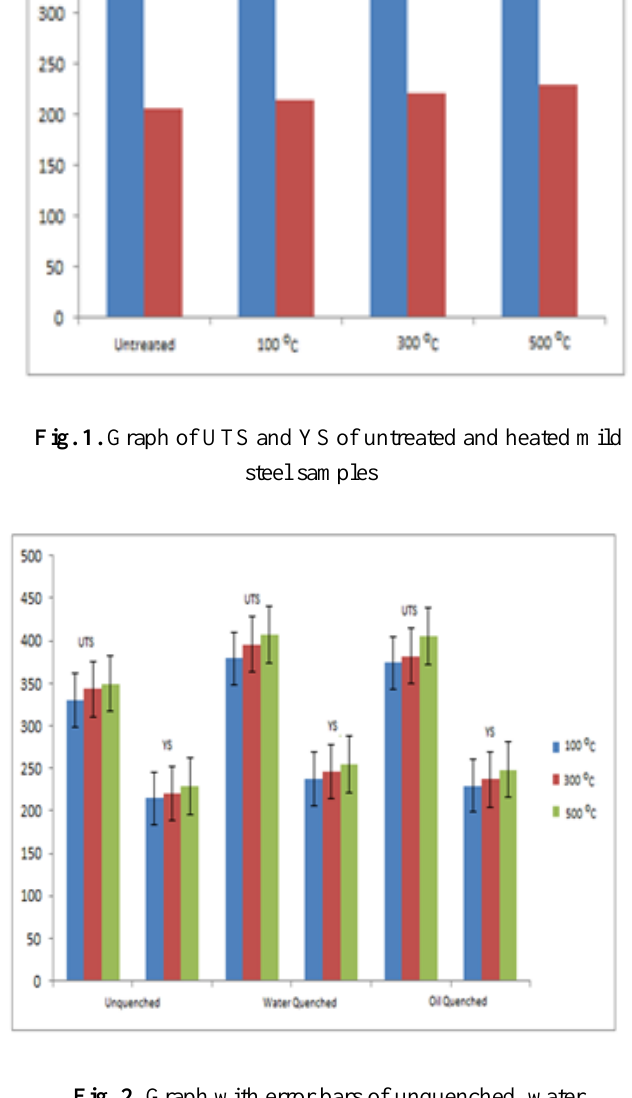
Fig. 2. Graph with error bars of unquenched, water quenched and oil quenched heated